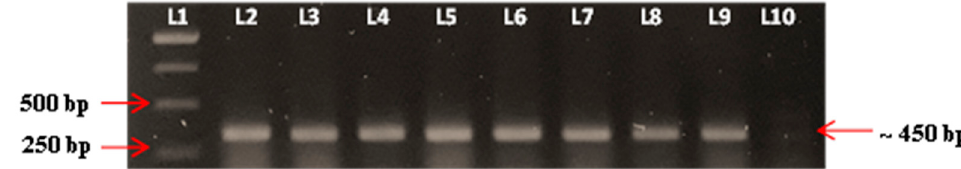
Figure 7. Confirmations of Vibrio spp. isolated from dead experimental fish by using PCR, gyrB forward and reverse primers. Lane 1: 1 kb DNA ladder marker (Fermentas, Waltham, MA, USA), Lane 2: Positive control (ATCC of V. harveyi ), Lane 3–9: Positive colonies of vibrio spp., Lane 10: Negative control.